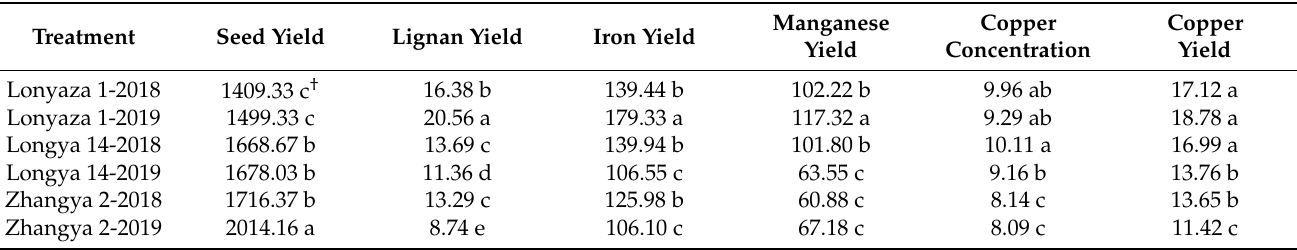
Table 7. Interactive effect of year and cultivar on the yields of seed, lignan, iron, and manganese, and the concentration and yield of